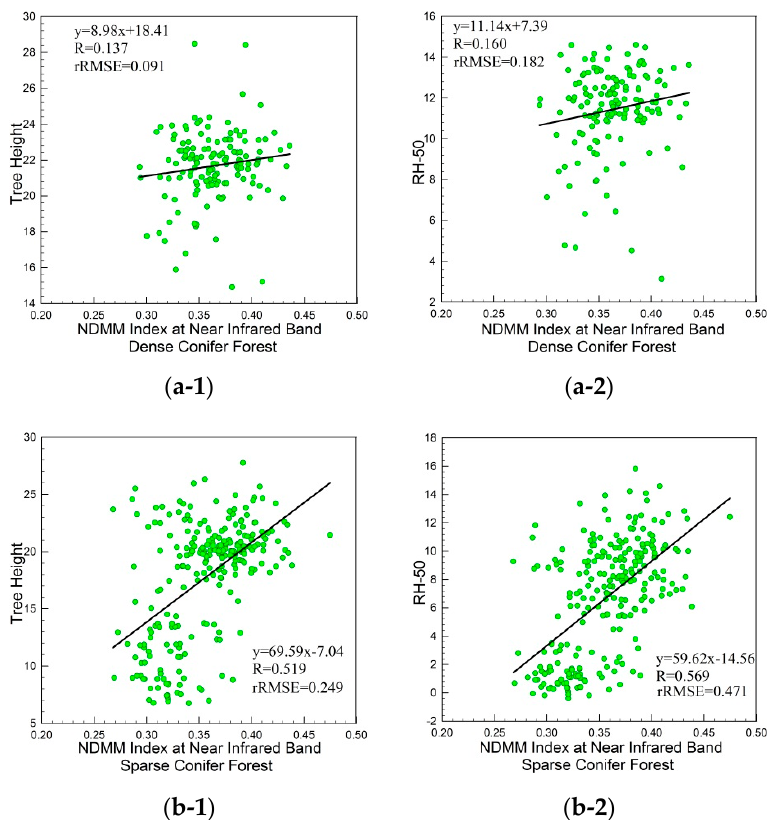
Figure 7. Relationship between tree height and the NDMM index at the near-infrared band for dense and sparse conifer forests in Howland. ( a-1 ) and ( b-1 ) represent the relationship between the tree height and NDMM Index at the near-infrared band for dense and sparse conifer forests respectively; ( a-2 ) and ( b-2 ) represent the relationship between RH-50 and NDMM Index at the near-infrared band for dense and sparse conifer forests respectively.